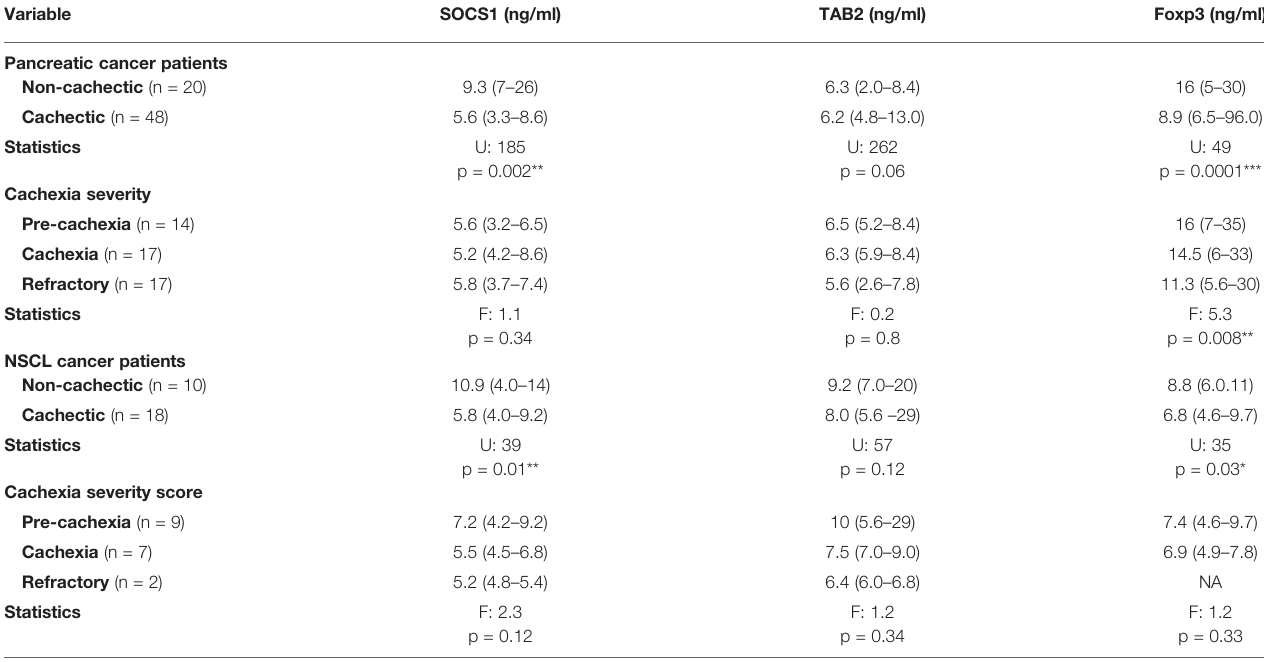
TABLE 5 | Serum SOCS1, TAB2, and Foxp3 level in cachectic and non-cachectic pancreatic and NSCL cancer patients and cachexia severity. Variable